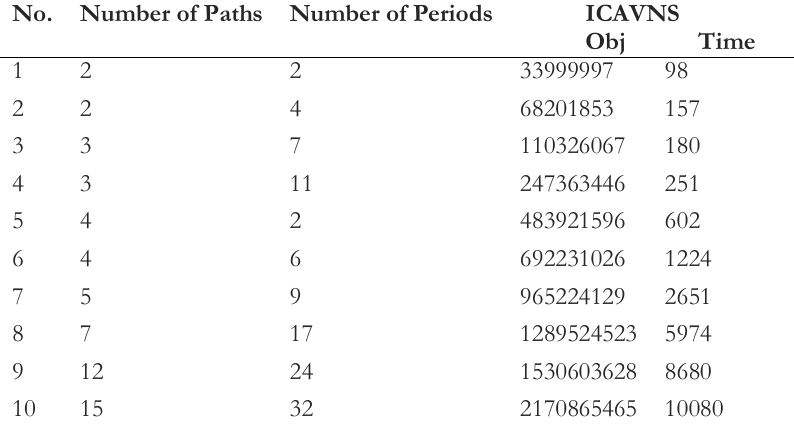
Table 14. Results of small